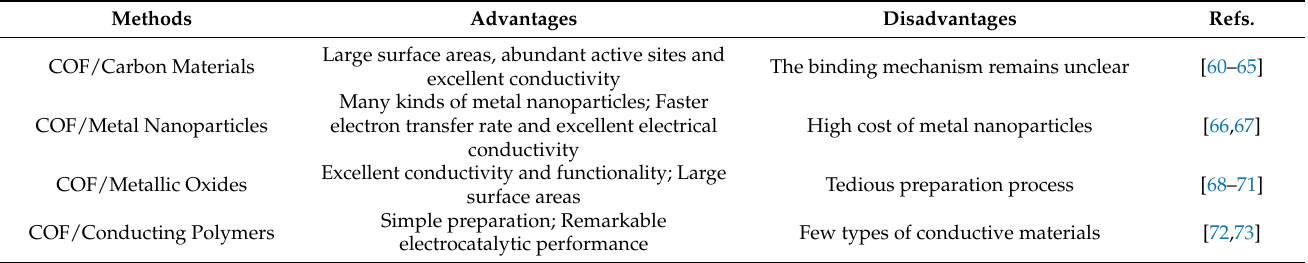
Figure 2. Strategies to improve COFs’ electrochemistry performance. Table 2. Methods to improve the electrochemistry performance of COFs and their advantages and disadvantages.